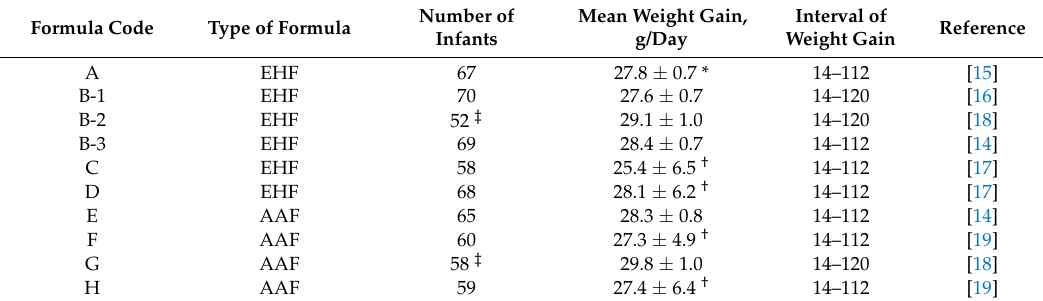
Table 2. Mean weight gain (g/day) from 14 days of age to 112–120 days of age reported for evaluable healthy term infants from the US fed EHFs and AAFs included in this